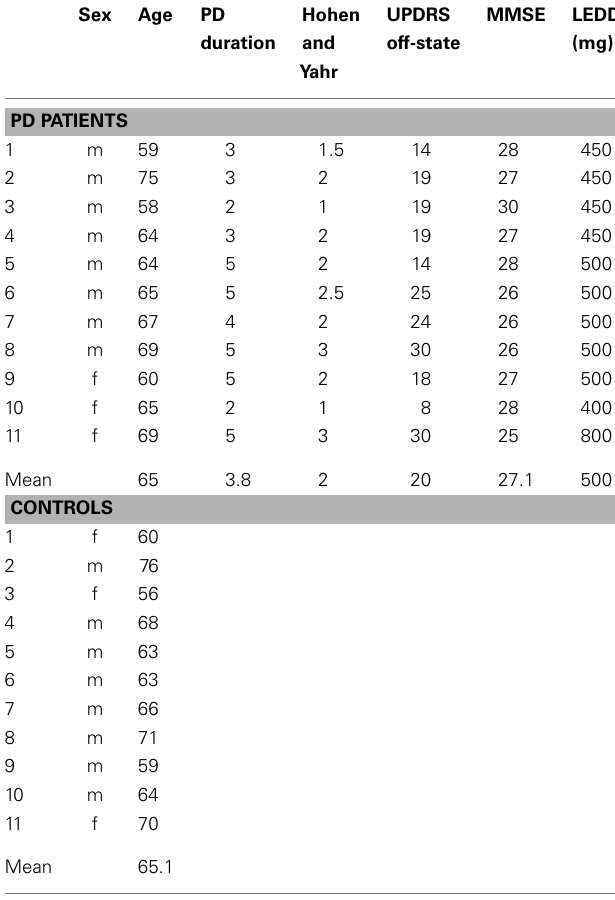
Table 1 | Clinical and demographic characteristics of patients and control subjects